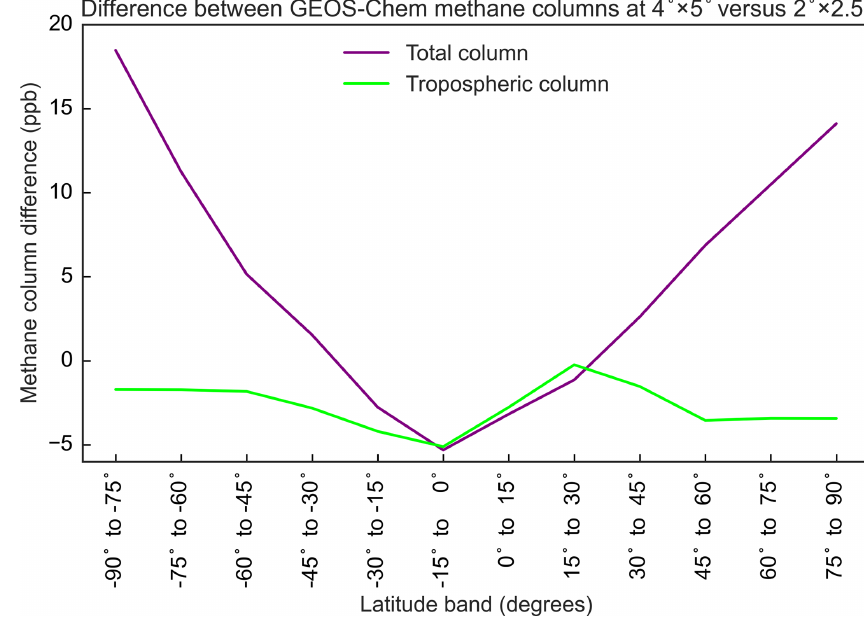
Figure A1. Difference between methane column concentrations simulated by GEOS-Chem at 4 ◦ × 5 ◦ versus 2 ◦ × 2 . 5 ◦ . Values are 2010–2015 averages over latitudinal bands for total atmospheric columns and tropospheric